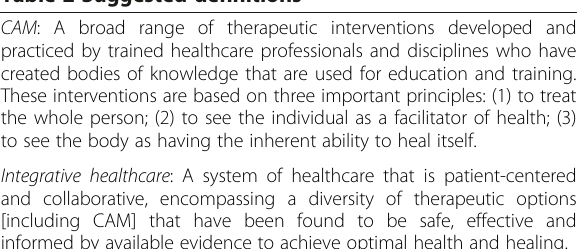
Table 2 Suggested